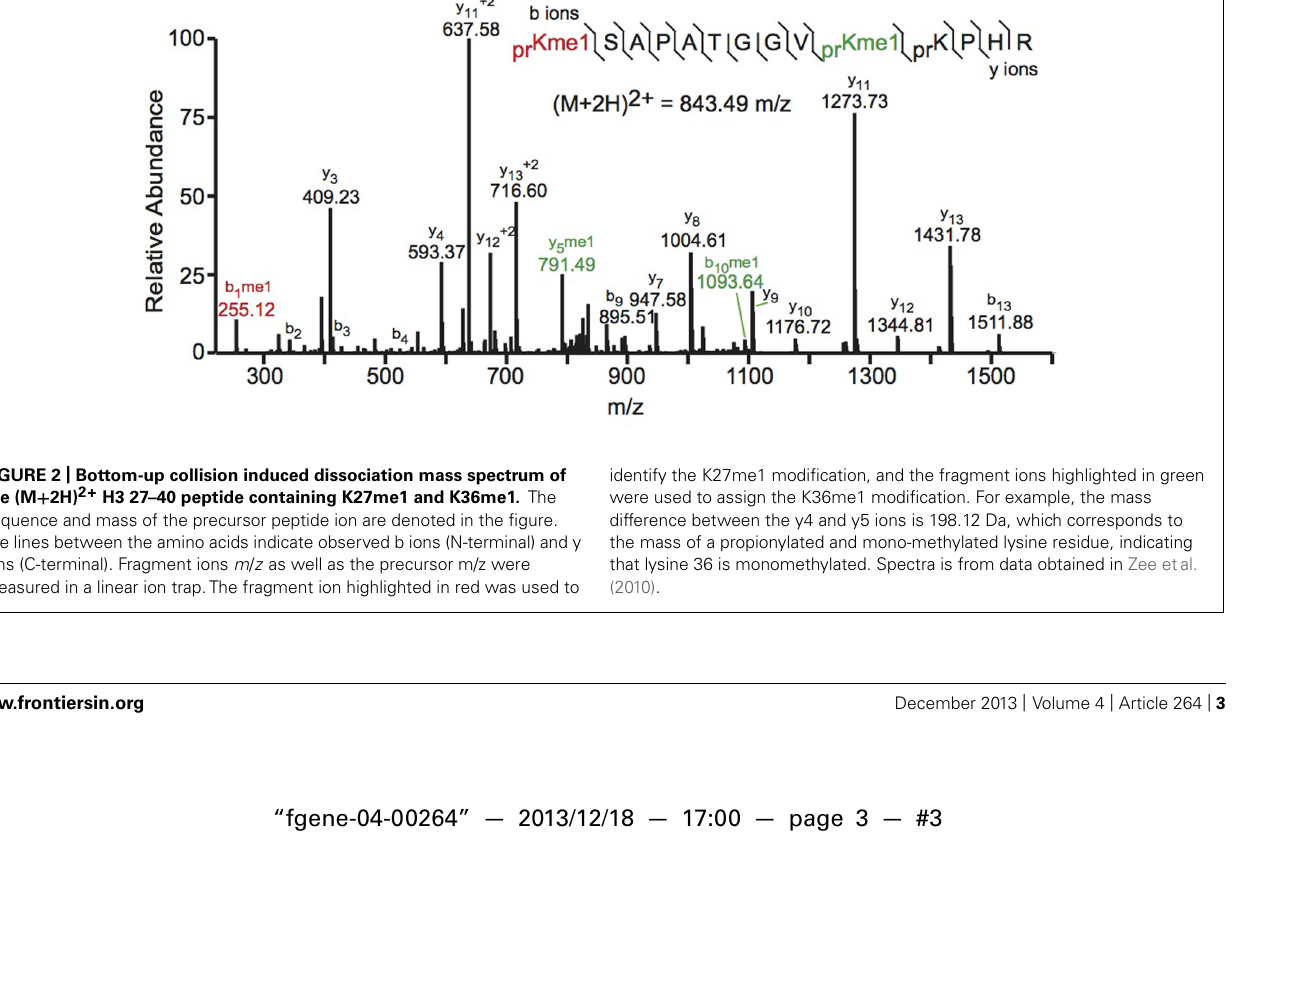
FIGURE 2 | Bottom-up collision induced dissociation mass spectrum of the (M + 2H) 2+ H3 27–40 peptide containing K27me1 and K36me1. The sequence and mass of the precursor peptide ion are denoted in the figure. The lines between the amino acids indicate observed b ions (N-terminal) and y ions (C-terminal). Fragment ions m / z as well as the precursor m/z were measured in a linear ion trap.The fragment ion highlighted in red was used to